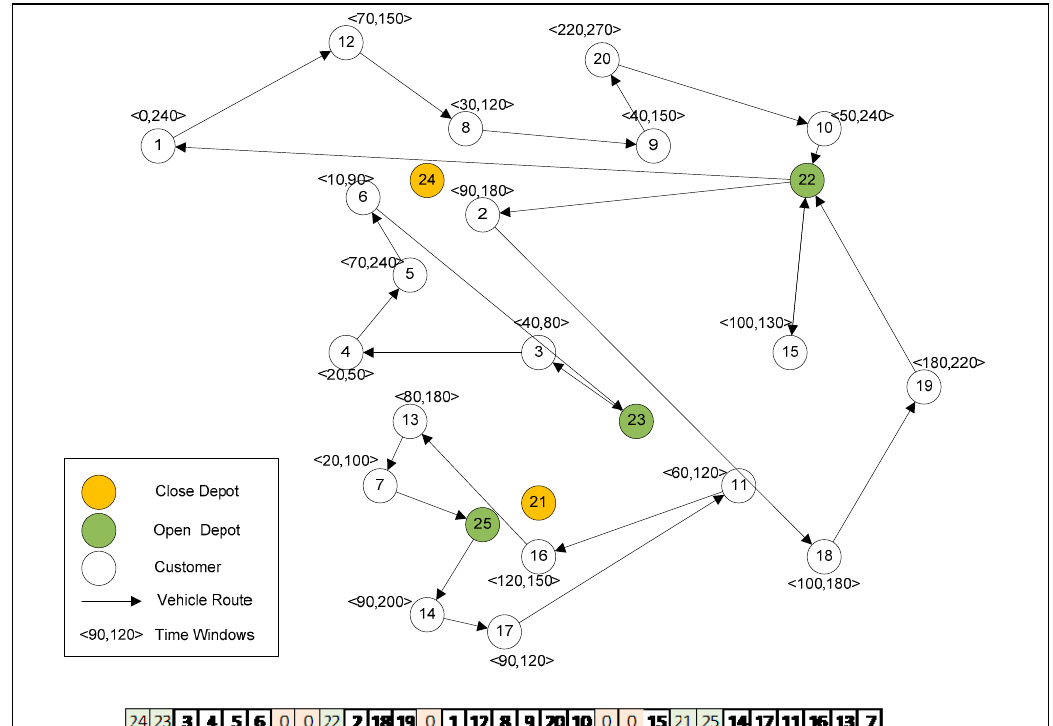
Figure 2. Illustration of example solution representation.